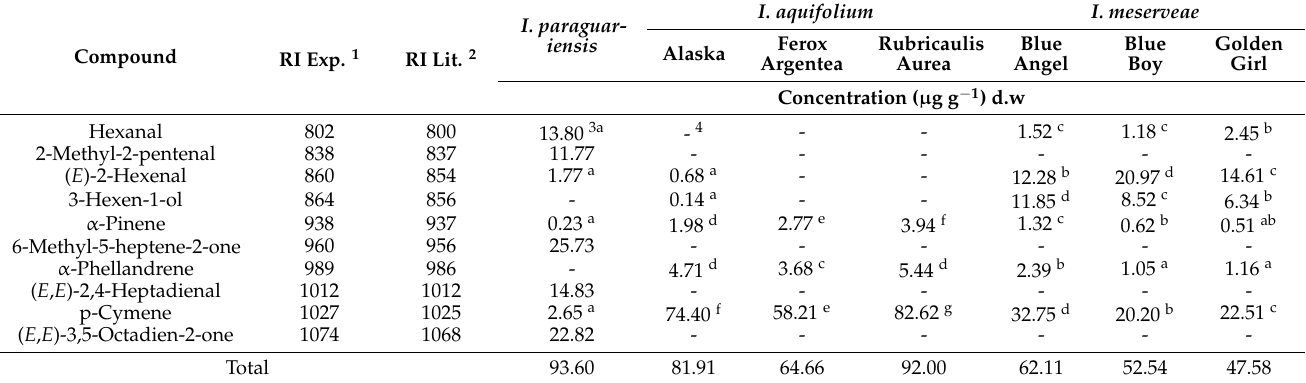
1 Experimental retention indices calculated against n-alkanes. 2 Retention indices according to the NIST20 database. 3 Values are mean; values followed by the same letter within a row are not significantly different ( p > 0.05, Tukey’s test). 4 not